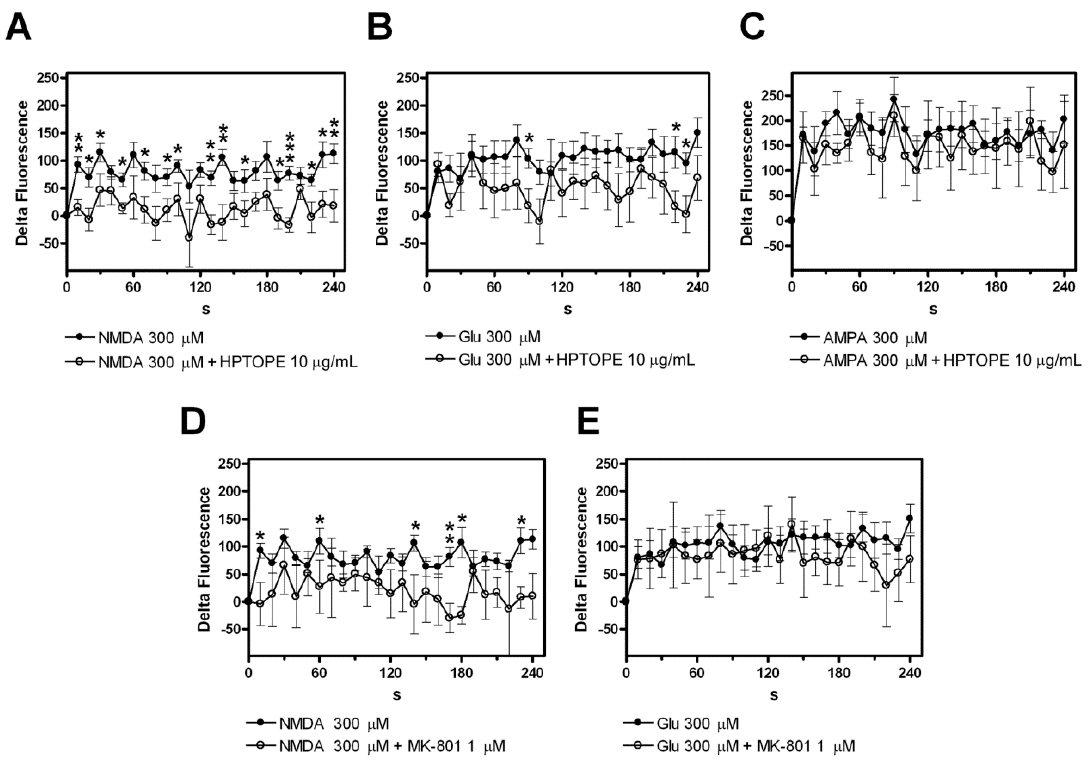
Figure 4. Evaluation of [Ca 2+ ] i increase in cortical neurons exposed to cytotoxic stimuli in the presence of HPTOPE. Calcium Green™-1AM(CG)-loaded neurons were treated with the indicated agonists in the absence ( ● ) or in the presence ( O ) of 10-µg/mL HPTOPE or 1-µM MK-801 for the indicated time at 37 °C. CG-dependent fluorescence was monitored every 10 s. [Ca 2+ ] i increase is expressed as “delta fluorescence”, which is the difference between the CG-dependent fluorescence of the stimulated samples and the ones of the vehicle-treated samples, both measured at each recording time and subtracted by the one measured at the starting time. ( A ) Data are means ± SEM from eleven ( ● ) or six ( O ) independent experiments in triplicate. ( B ) Data are means ± SEM from ten ( ● ) or six ( O ) independent experiments in triplicate. ( C ) Data are means ± SEM from four independent experiments in triplicate. ( D ) Data are means ± SEM from eleven ( ● ) or three ( O ) independent experiments in triplicate. ( E ) Data are means ± SEM from ten ( ● ) or four ( O ) independent experiments in triplicate. * p < 0.05, ** p < 0.01, and *** p < 0.001 according to t -test.